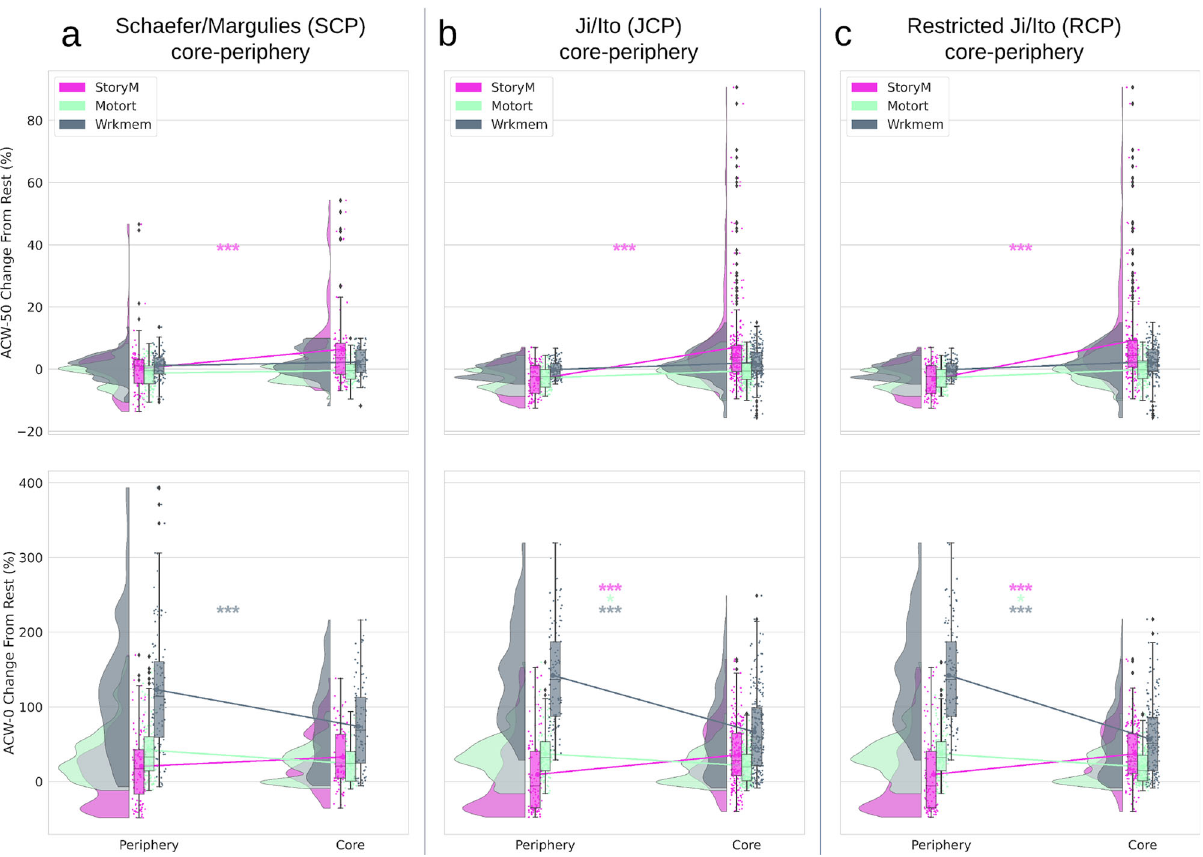
Fig. 6 Change in ACW from rest to task states in different CP divisions by calculating rest – task differences. Rainclouds represent regions divided into core and periphery. Values are presented in percentages. Stars represent the signi fi cance level (*** ≡ α = 0.001, * ≡ α = 0.05). a Showing rainclouds for the ACW change values of core and periphery using the Schaefer/Margulies division (SCP). A statistical test (Supplementary Table 5) was performed with two-way ANOVA using task condition (3 levels: StoryM, Motort and Wrkmem) and CP (2 levels: core and periphery) as independent factors. It showed signi fi cant ( p < 0.001) effect of CP factor on ACW-50 ( F (1,594) = 10.63, η 2 = 0.01) and ACW-0 ( F (1,594) = 12.17, η 2 = 0.01). b Ji/Ito template (JCP): again, two-way ANOVA showed signi fi cant ( p < 0.001) effect of CP factor on ACW-50 ( F (1,1074) = 99.61, η 2 = 0.07) and ACW-0 ( F (1,1074) = 26.74, η 2 = 0.01). c Restricted Ji/Ito template (RCP): signi fi cant ( p < 0.001) effect of CP for ACW-50 ( F (1,1074) = 97.35, η 2 = 0.08) and ACW-0 ( F (1,1074) = 34.92, η 2 = 0.02). Post-hoc analysis was performed using Tukey ’ s HSD method to determine whether the difference between core and periphery is signi fi cant. The results are provided in Table